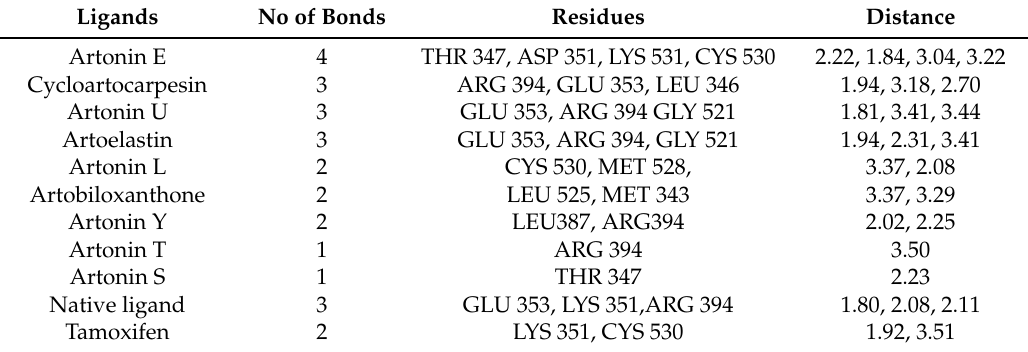
Table 4. Hydrogen bonding interactions between studied ligands and the critical amino acids at the ligand-binding domain of hER α